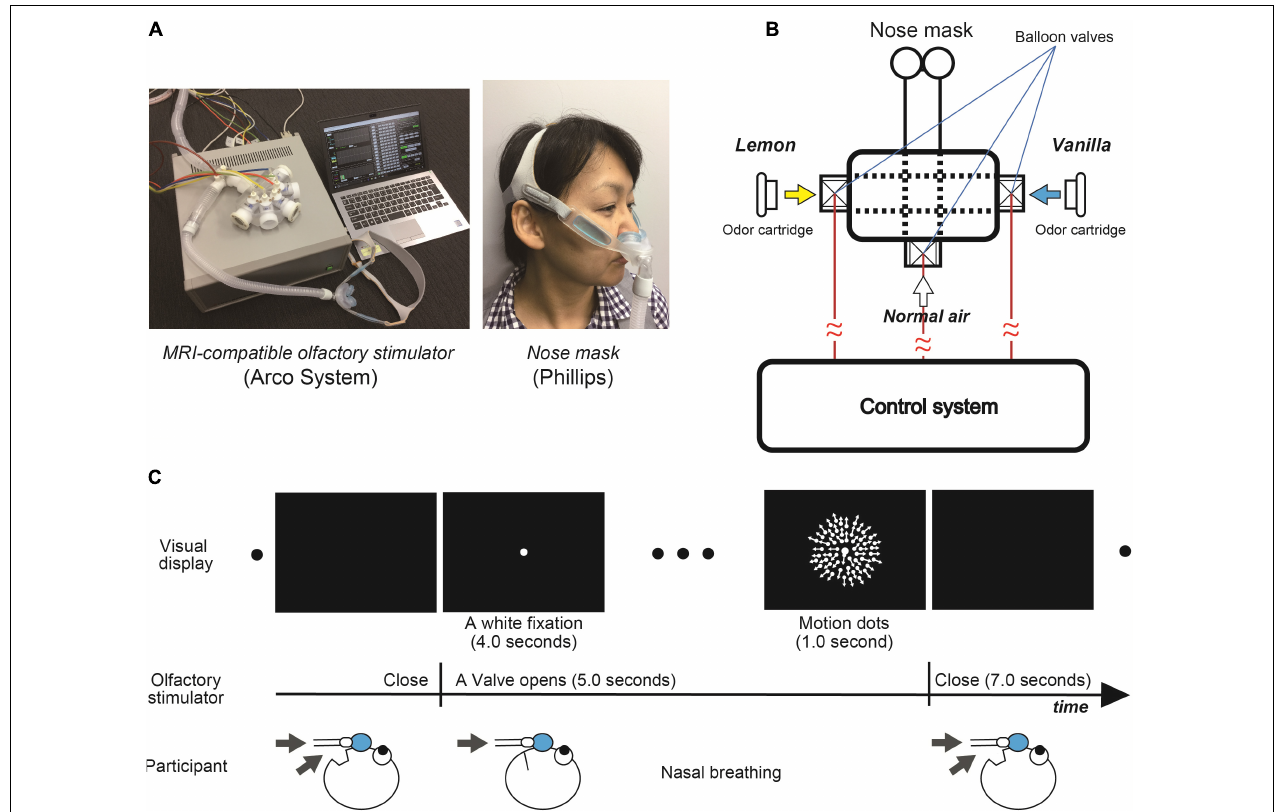
FIGURE 3 | (A) Magnetic resonance imaging -compatible olfactory stimulator (Arco System) and nose mask (Phillips). (B) Schematic diagram of olfactory stimulator. Each balloon valve was opened and shut in experimental order. (C) Experimental paradigm of functional magnetic resonance imaging (fMRI) experiment.